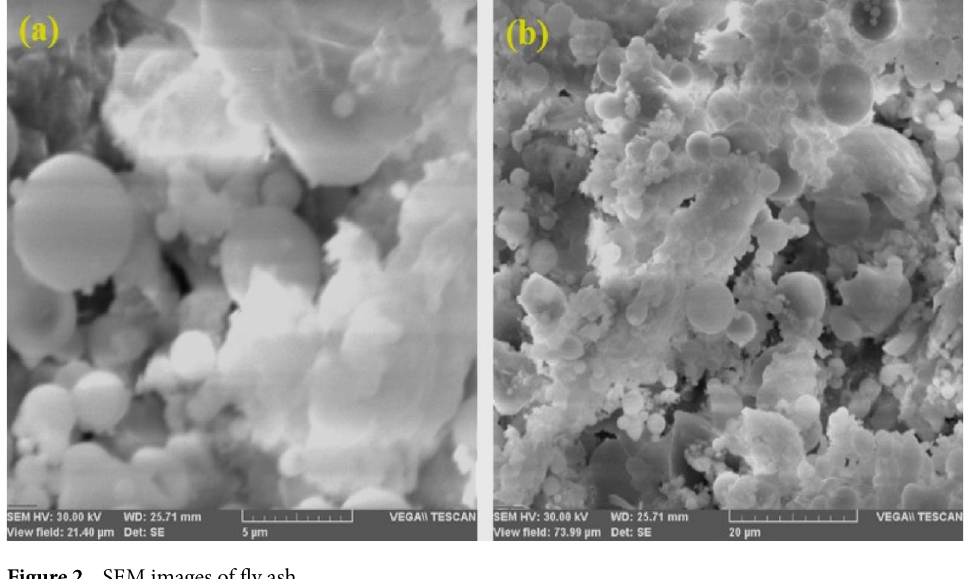
Figure 2. SEM images of fly ash.